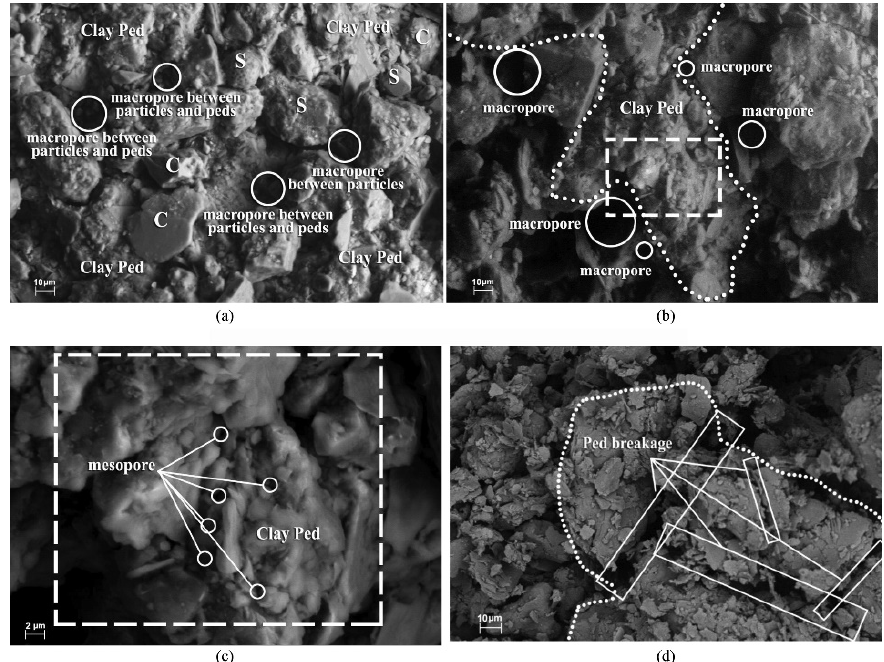
Figure 12. ESEM micrographs of a compacted low-plasticity clayey silt, dried to a water content of 0.38% and wetted to the compacted water content (20%), where ( a ) shows clay peds (aggregates), clay particles C, silt particles S, and macropores; ( b ) clays ped (aggregate) and macropores; ( c ) mesopores; and ( d ) ped (aggregate) breakage after undergoing drying and wetting cycles (reproduced from Azizi, et al. [17], © Canadian Science Publishing or its licensors).